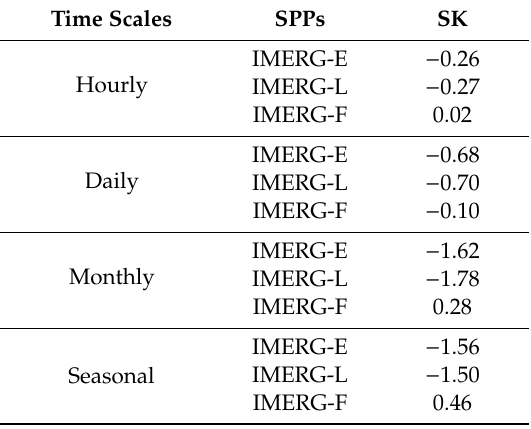
Figure 2. Distribution of precipitation errors from IMERG SPPs at ( a ) hourly, ( b ) daily, ( c ) monthly, and ( d ) seasonal scales from 1 June 2014 to 31 December 2018. Table 4. SK of precipitation errors from IMERG SPPs at hourly, daily, monthly, and seasonal scales from 1 June 2014 to 31 December 2018.